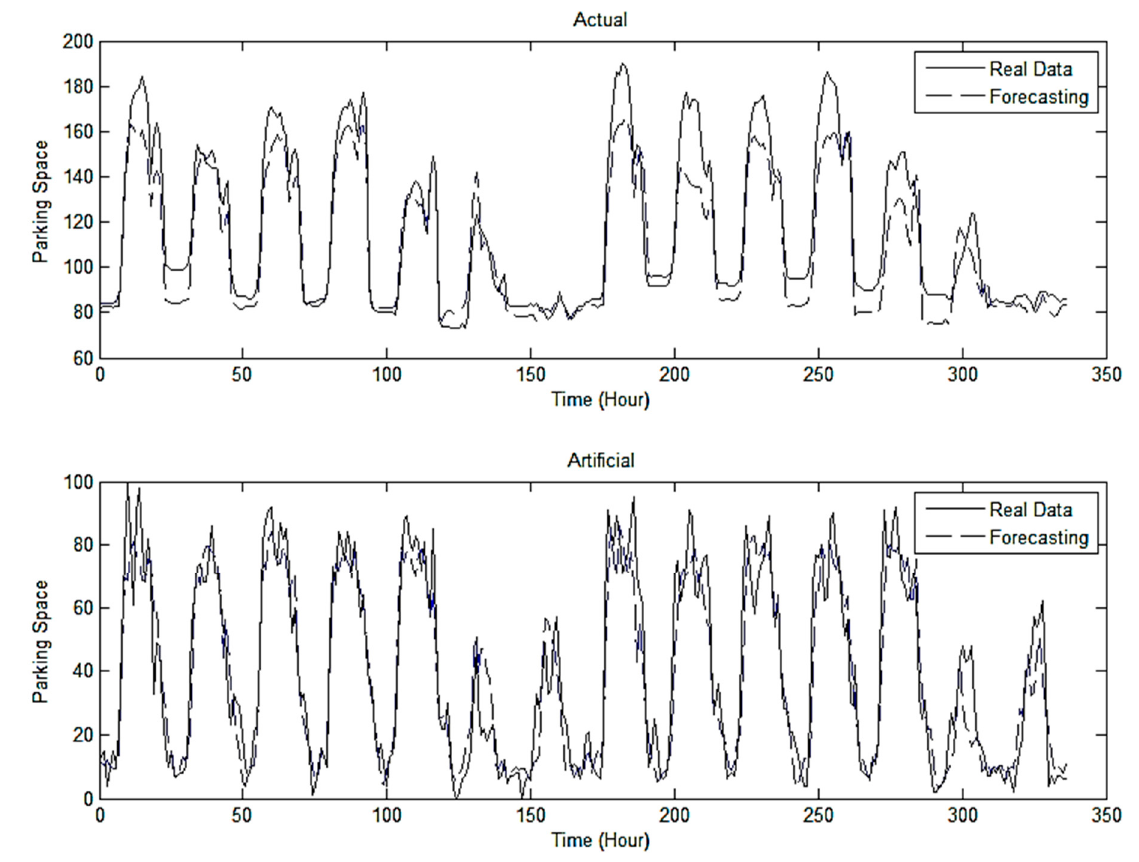
Figure 14. Pattern of forecasted real and artificial datasets.